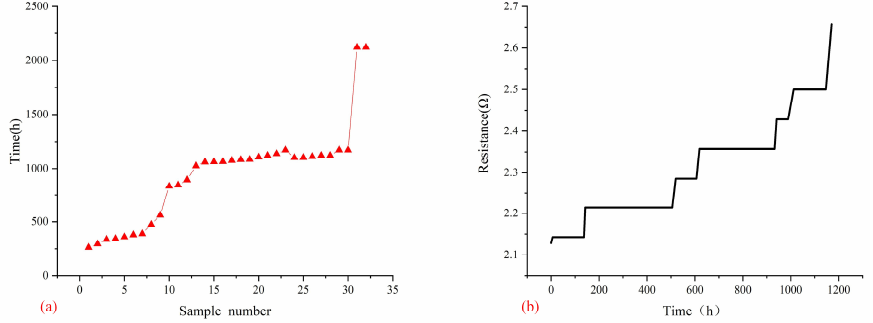
Figure 8. Results of electromigration experiment ( a ) Lifetime distribution of the test samples ( b ) The 16th sample of electrical resistance of daisy chain circuit as the function of time. 16th sample of electrical resistance of daisy chain circuit as the function of